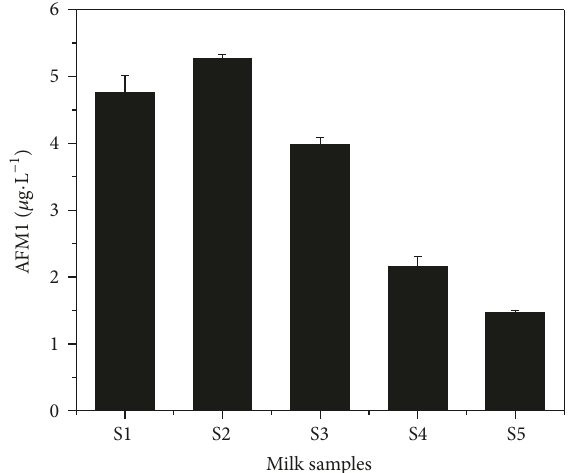
Figure 2: ELISA results of the level of AFM1 in the contaminated milk